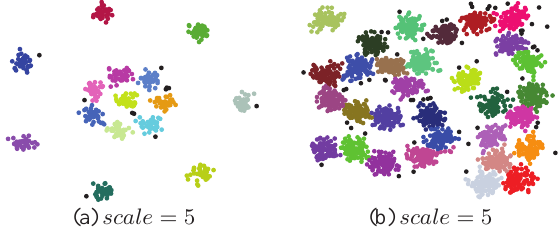
Figure 3: Clustering results of the proposed method on the Gaus- sian distributed test